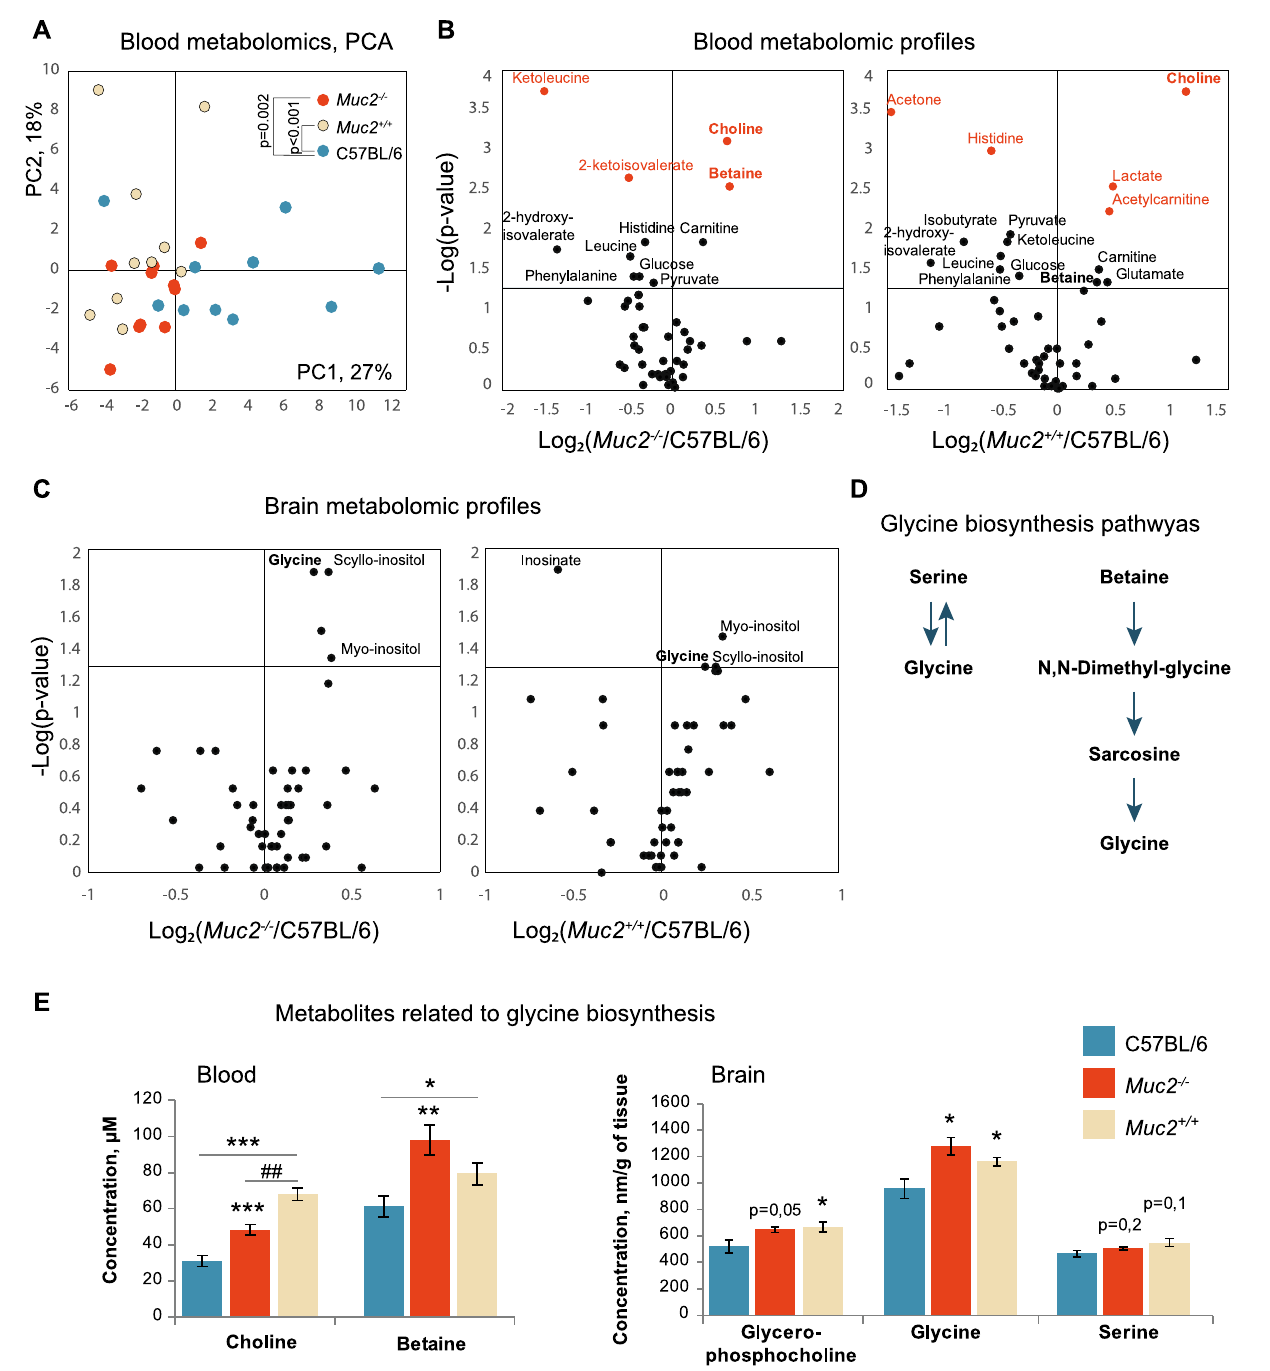
Figure 4. Metabolomic profiling of blood and brain of Muc2 −/− and Muc2 + / + mice. ( A ) PCA analysis of blood NMR metabolic profiles ( n = 10/group). There was a significant effect of a group on PC1, which accounted for about 26.6% of variance ( F (2, 27) = 8.84, p < 0.001, one-way ANOVA). Metabolomic profile of the C57BL/6 was significantly different from the two other groups ( Muc2 −/− : p = 0.002; Muc2 + / + : p < 0.001, Fisher’s LSD test). ( B ) Volcano plots of blood metabolites as revealed by NMR. Horizontal line depicts a cut-off at p = 0.05. Vertical line depicts the ratio of 1. Metabolites with differences at p < 0.01 are shown in red. ( C ) Volcano plots of brain metabolites as revealed by NMR ( n = 5–6). ( D ) The schemes of glycine biosynthesis from serine and betaine. ( E ) The levels of metabolites related to glycine biosynthesis. The data of the Kruskal–Wallis test followed by Mann– Whitney u -test are presented in Supplementary tables 3 and 4. * = p < 0.05, ** = p < 0.01 vs . C57BL/6. ## = p < 0.01 vs . Muc2 + / +